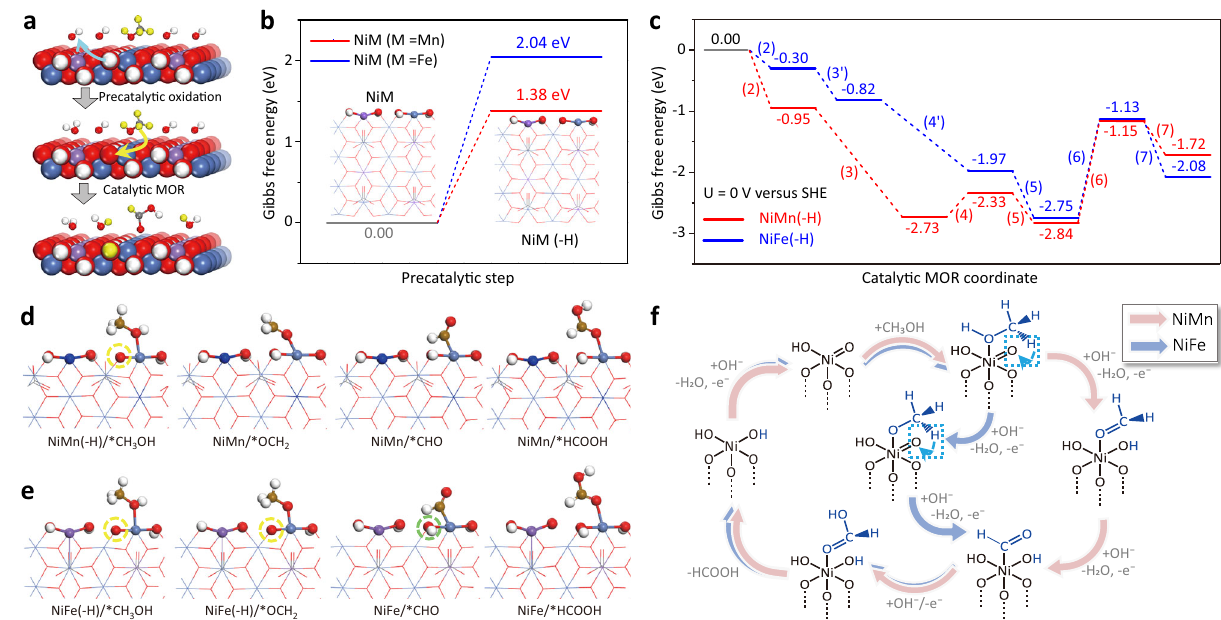
c catalyticMORprocess.OptimizedstructuresoftheintermediatesinMORprocess on d NiMnand e NiFe-LDHs,where,Ni:wathet,Fe:purple,Mn:blue,N:gray,O:red, H: white, C: brown. The yellow and green circles indicate the hydrogen-de fi cient and hydrogen-added oxygens in NiM(-H), respectively. f An unconventional bifunctional mechanism proposed for the overall MOR